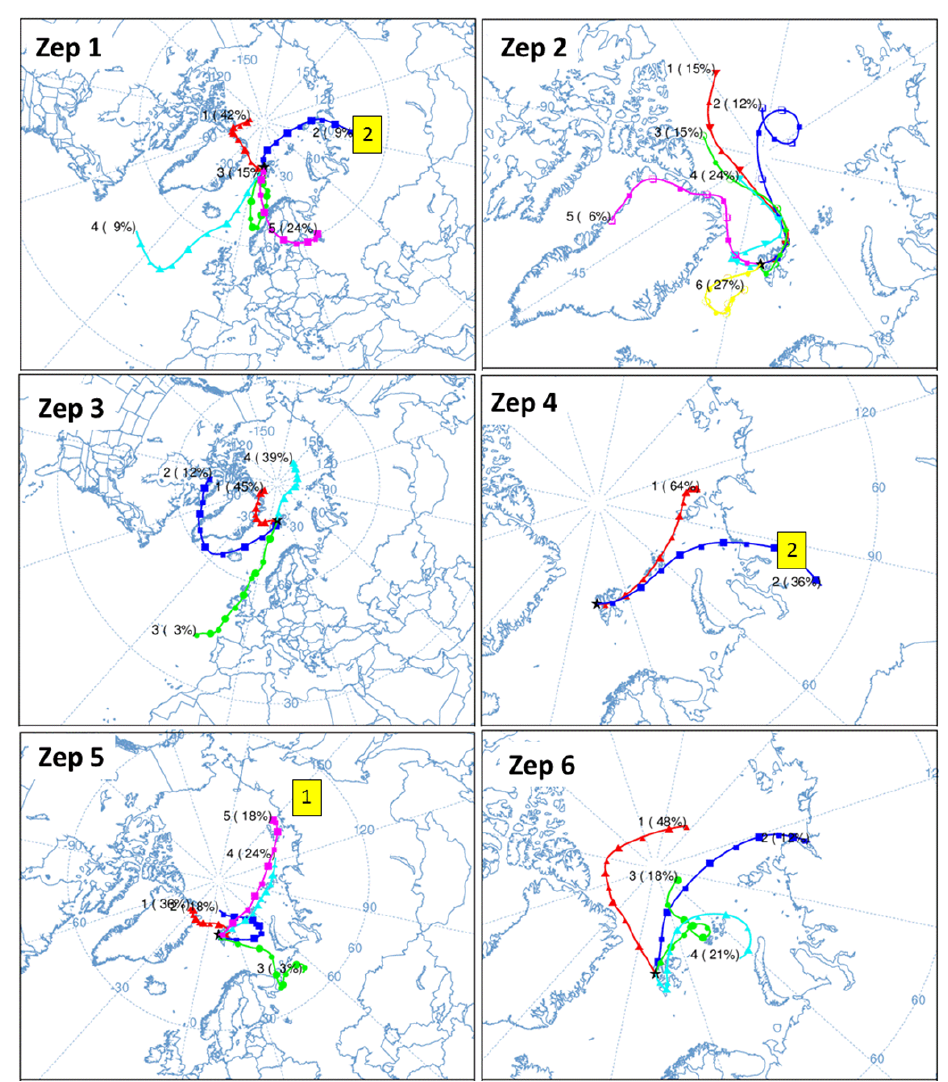
Figure 8. Five-day backwards air mass trajectories ending at Zeppelin Mountain at 10m height above ground level, calculated using the HYSPLIT model. Backwards air mass trajectories were made for every fourth hour and clustered for each sampling week of 2008 (each coloured trajectory represents a cluster mean). Sampling weeks with similar trajectory patterns are represented by one map in the